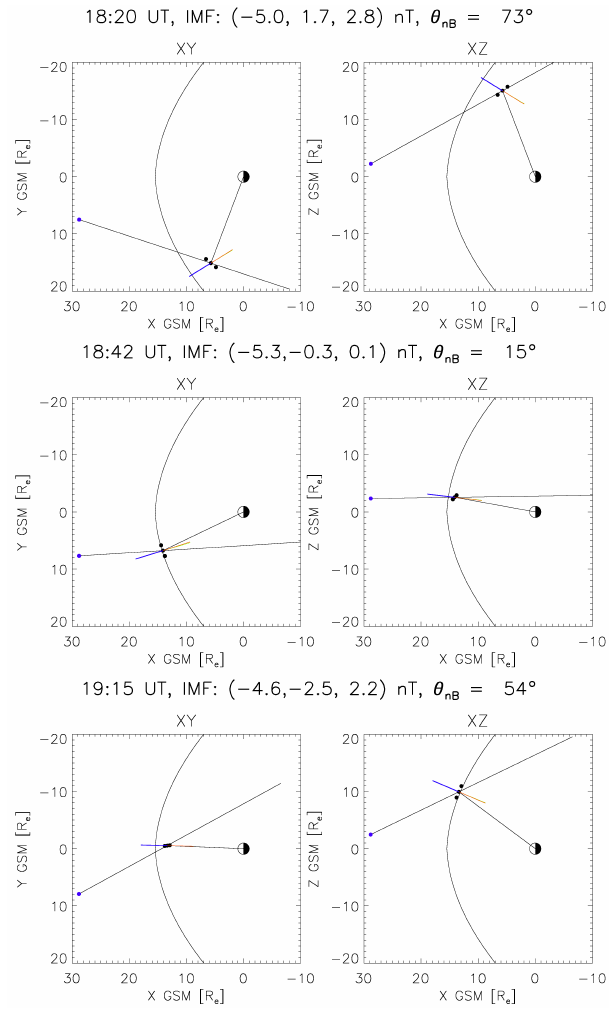
Fig. 11. Geometry for different IMF orientations at different times on 5 September 2002. The blue dot on the left marks the position of the Geotail satellite, the black dots represent the points on the bow shock surface from which the normal was calculated. The two according normals are yellow and red, the average normal is in blue. Also shown is the bow shock surface in the respective plane, the position vector of the cross point and